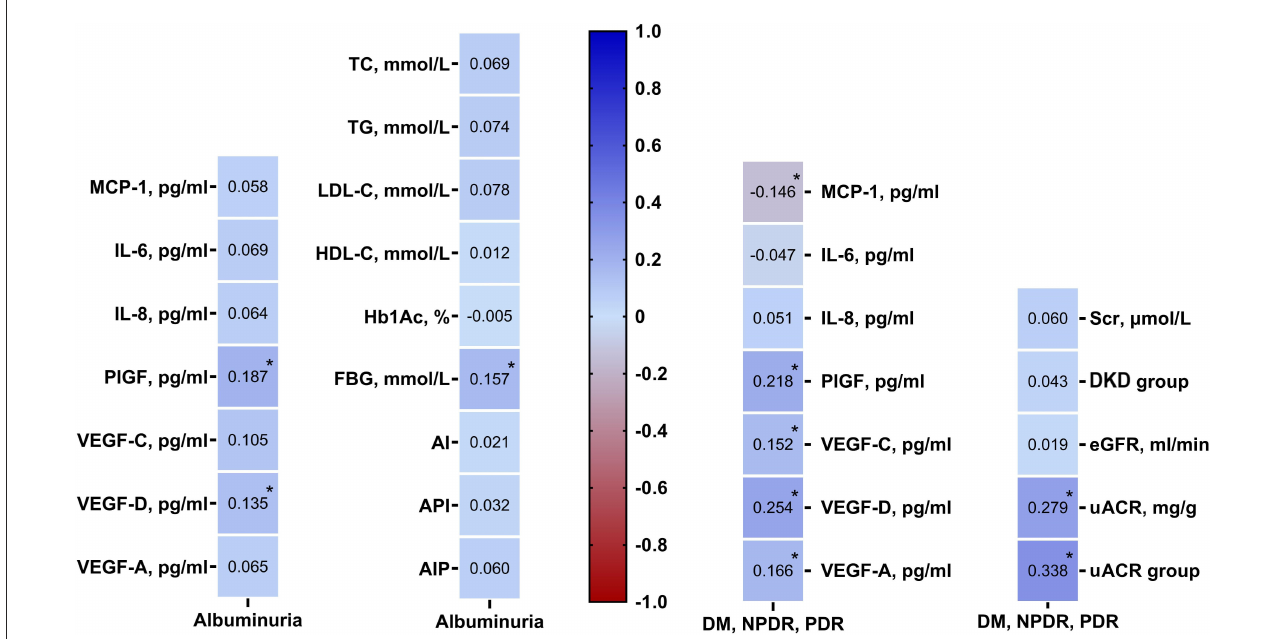
FIGURE2 Kendall’s Tau-b rank correlation coefficient analysis showing angiogenic cytokines were associated with DR and DKD grades, renal function profiles were related with DR grades. DM, diabetes mellitus; DR, diabetic retinopathy; DKD, diabetic kidney disease; TC, total cholesterol; TG, triglycerides; HDL-C, high density lipoprotein cholesterol; LDL-C, low-density lipoprotein cholesterol; AI, atherosclerosis index [(TC-HDL-C)/HDL-C]; AIP, atherogenic index of plasma [log (TG/HDL-C)]; API, atherogenic plasma index (LDL-C/HDL-C); HbA1c, hemoglobin; FBG, fasting blood glucose; Scr, serum creatinine; eGFR, estimated glomerular filtration rate; uACR, urinary albumin/creatinine ratio; MCP-1, monocyte chemoattractant protein-1; IL-6, interleukin-6; IL-8, interleukin-8; PlGF, placental growth factor; VEGF, vascular endothelial growth.